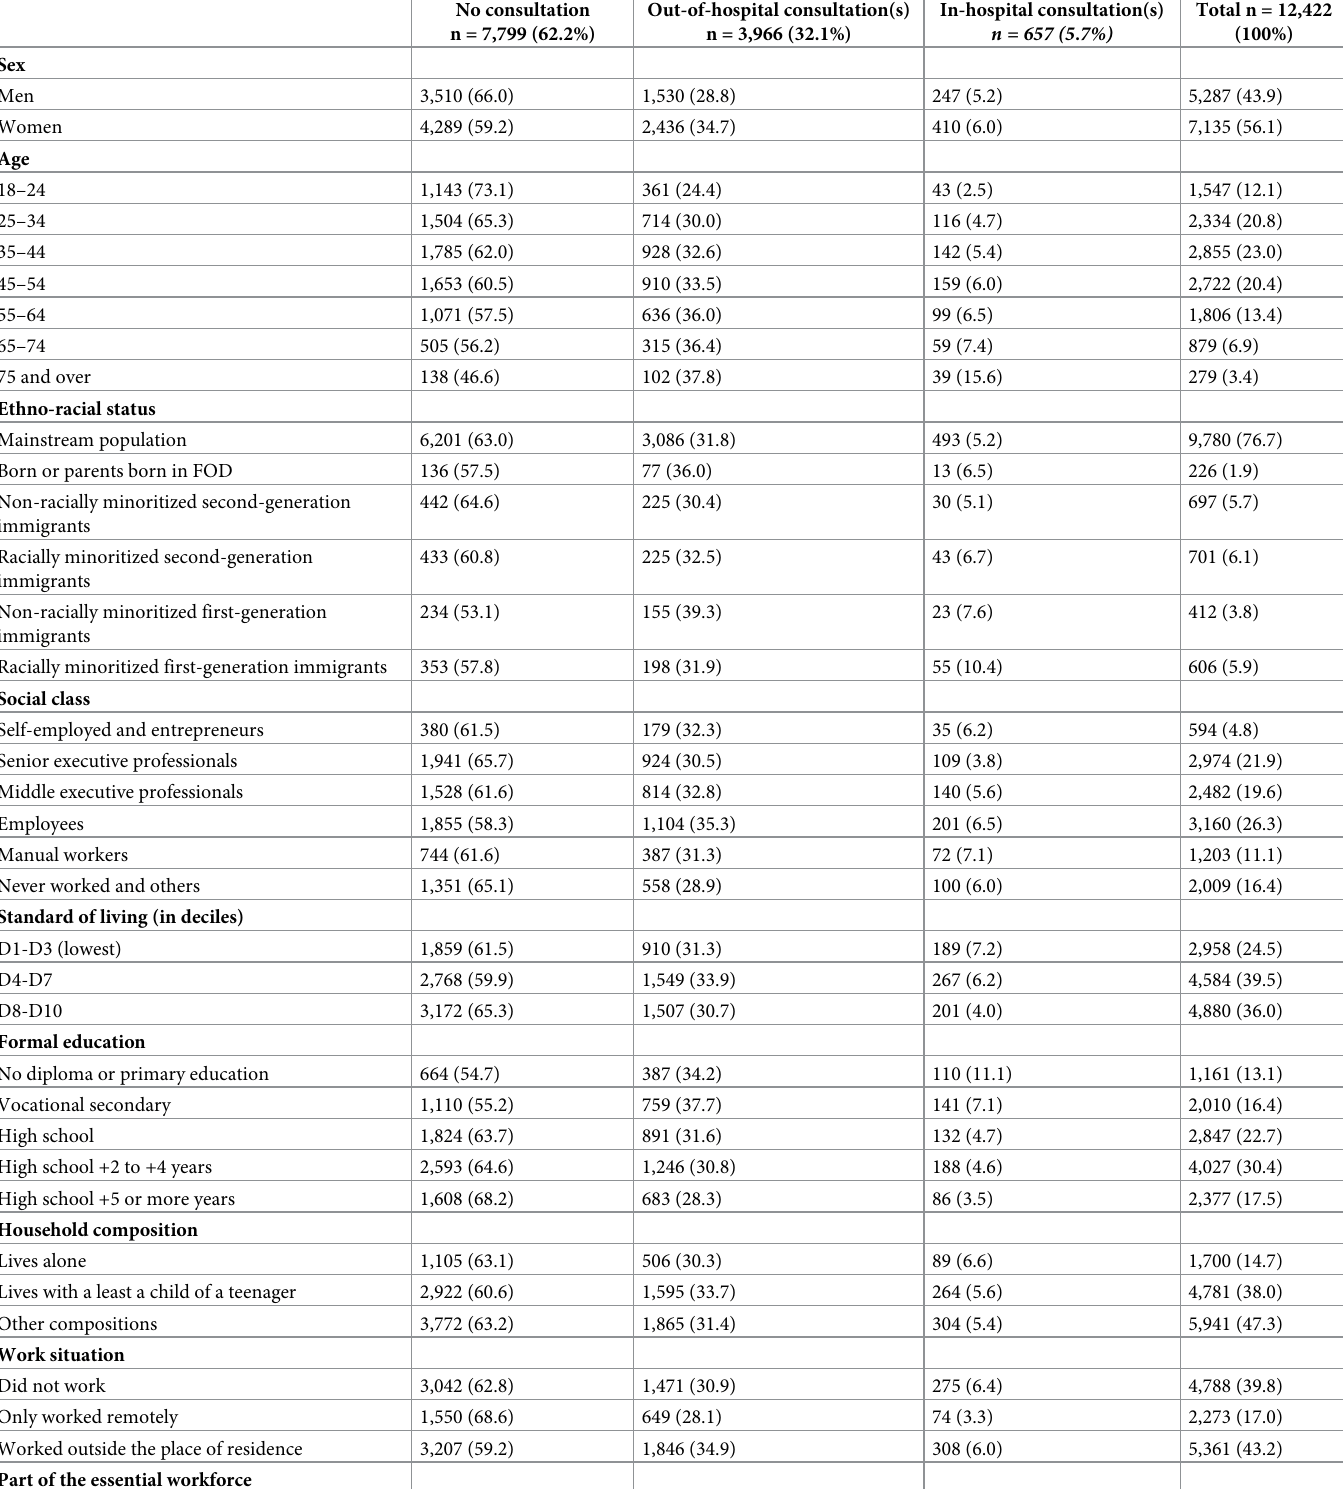
Table 1. Distribution of the use of health care services by socio-demographic